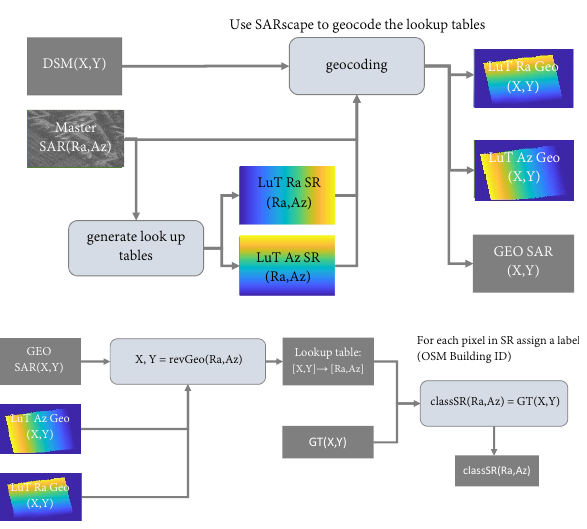
Figure 2. Workflow for Reverse Geocoding: Lookup tables (LuTs) for Range and Azimuth are geocoded, using the master images’s SAR properties and a precise digital surface model (DSM). The geocoded LuTs are used to transform the ground truth (GT) from UTM to slant-range geometry, including SAR characteristics like foreshortening and layover. (2020) have shown for similar data, that ”1 minus the sample correlation ” (Eq. (2)) is a good heuristic metric for a density- based spatial clustering of applications with noise (DBSCAN) clustering (Ester et al., 1996) in this space.